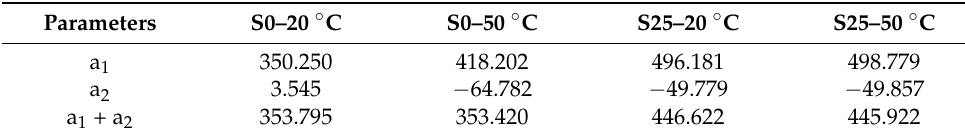
Figure 15. Cumulative heat release fitting. Table 4. Limit heat release (J/g).